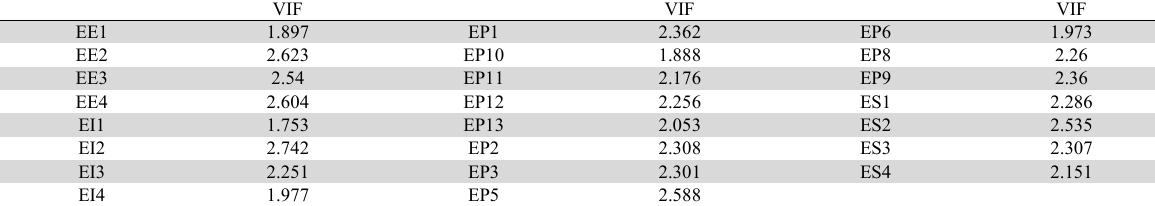
Collinearity Statistics (VIF) Outer VIF Values